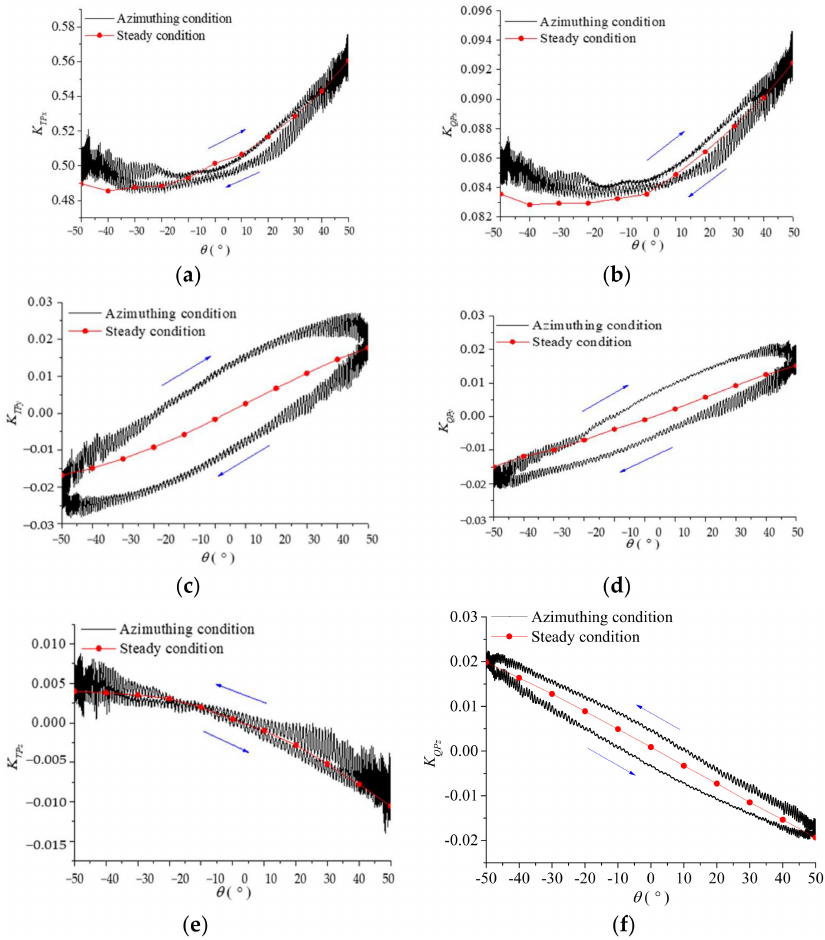
Figure 13. Comparison between steady load and the transient load of the propeller ( J = 0.2): ( a ) K TPx